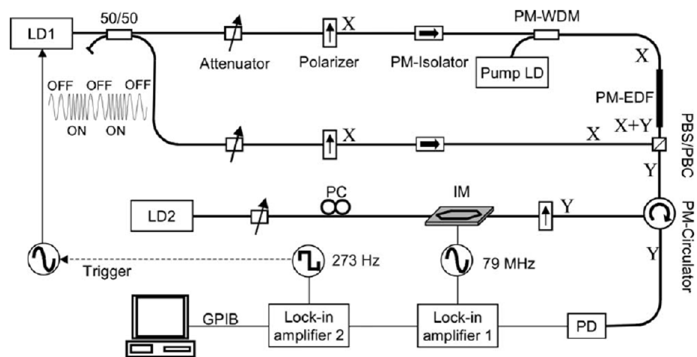
Figure 38. Experimental setup for distributed strain measurement in a polarization maintaining erbium-doped fiber (PM-EDF) [94]. In the fiber, the two lightwaves in one polarization axis are propagated in opposite directions with respect to each other, which makes a standing wave that induces gain grating along the fiber. The Bragg reflection spectrum is read by the third lightwave launched in the orthogonal polarization. The difference of the Bragg reflection frequency between the two polarization lightwaves corresponds to the fiber birefringence, which tells us the strain. The SOCF scheme is applied to have the position selective measurement of the birefringence.